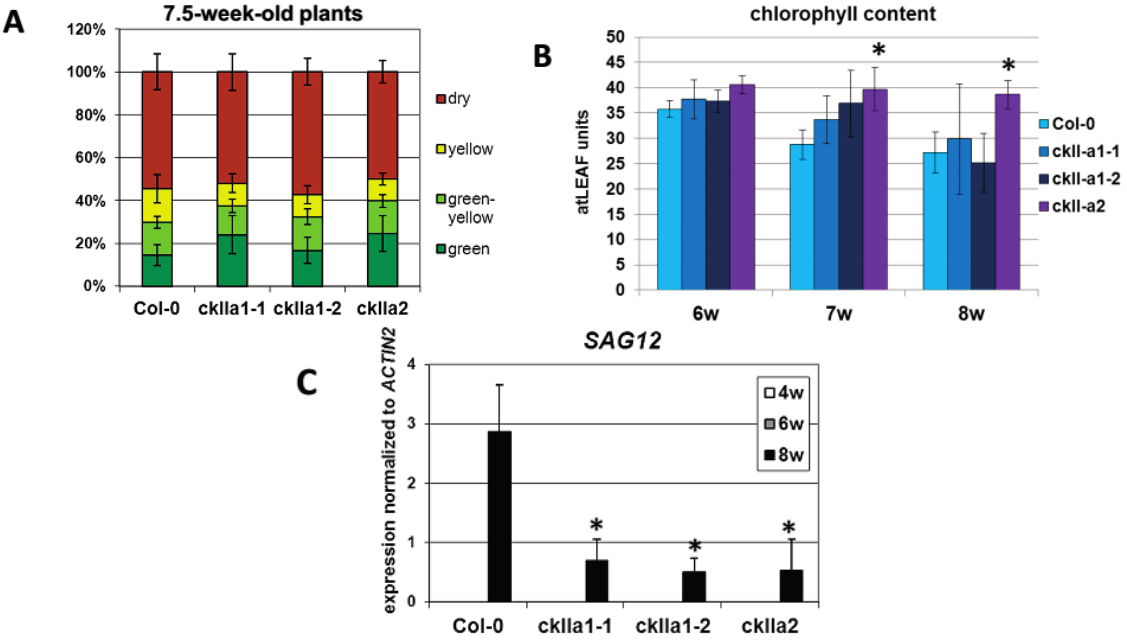
Figure 4. Senescence phenotypes of wild type Col-0, ckII α 1 and ckII α 2 mutant plants. Four plant lines were analyzed over development. ( A ) For a quantitative evaluation of leaf senescence, leaves of at least five plants were categorized in four categories according to their leaf color: (1) “green”; (2) leaves starting to get yellow from the tip as “yellow-green”; (3) completely yellow leaves as “yellow” and (4) dry and/or brown leaves as “dry”. The percentages of each group with respect to total leaf numbers are